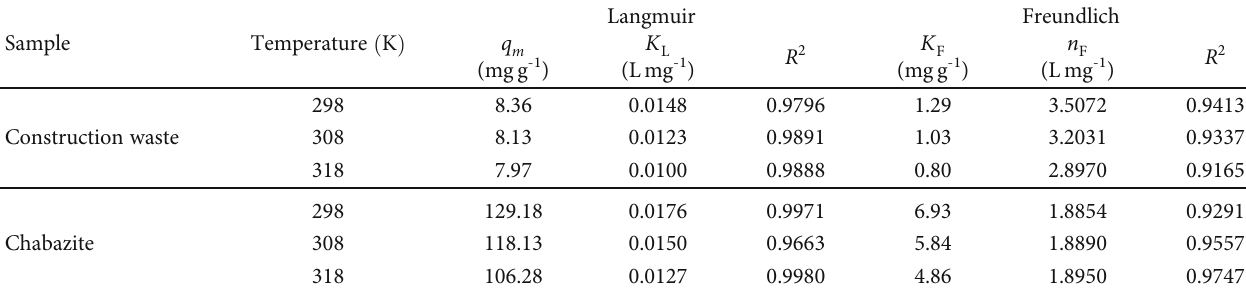
Table 3: Fitting parameters of Langmuir and Freundlich models of MB adsorption isotherms on construction waste and chabazite. Sample